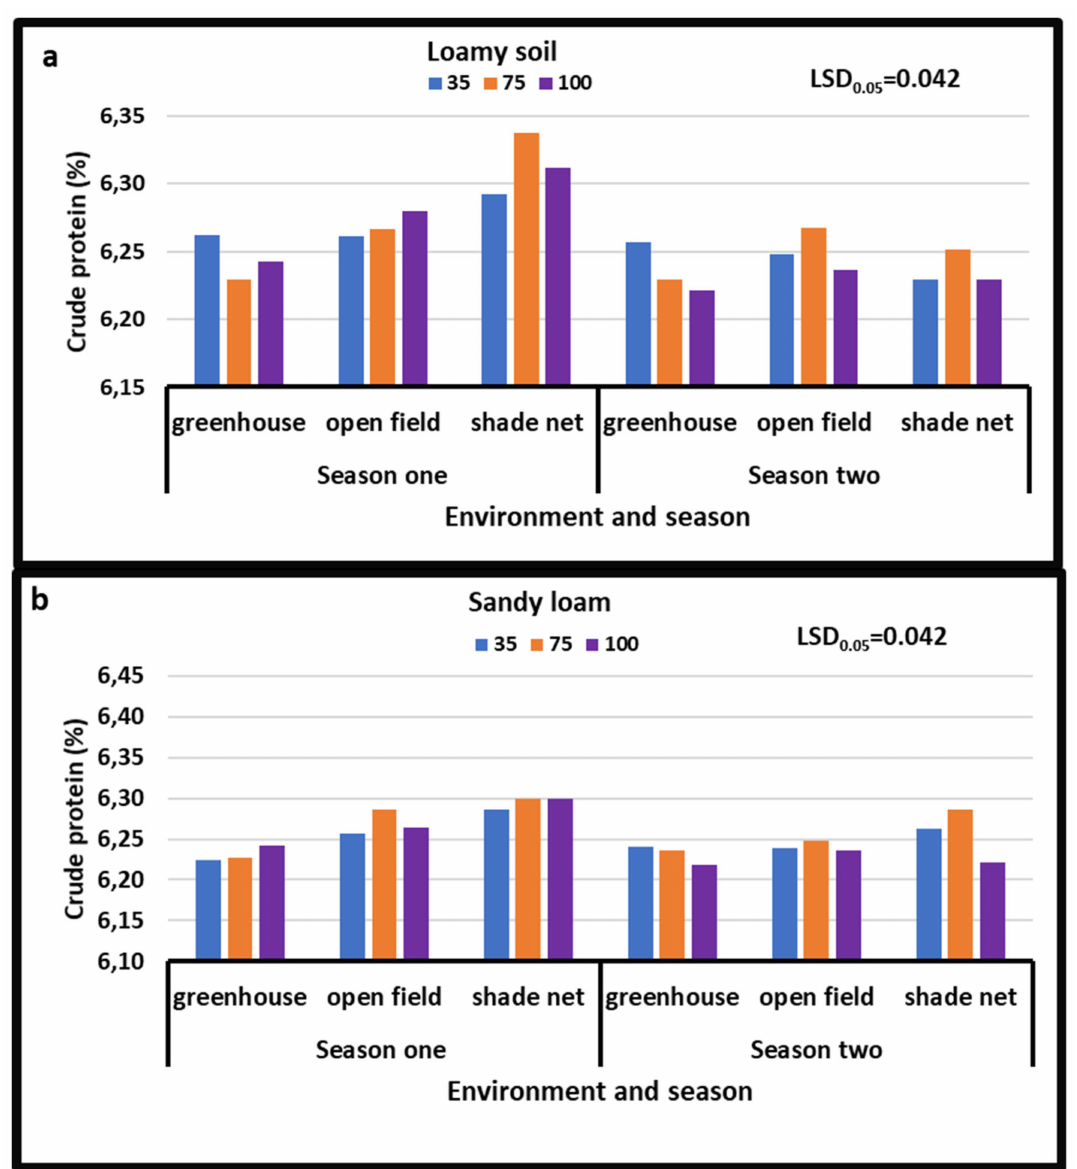
Figure 2. Treatment interaction effect on crude protein content of African horned cucumber fruit; ( a ) interaction effect of different water stress levels and loamy soil, in different environments, during season one (2017/2018); ( b ) interaction effect of different water stress levels and sandy loam, in different environments, during season two (2018/19); 35 means severe water stress, 75 means moderate water stress, and 100 means no water stress (control). LSD 0.05 is the least significant